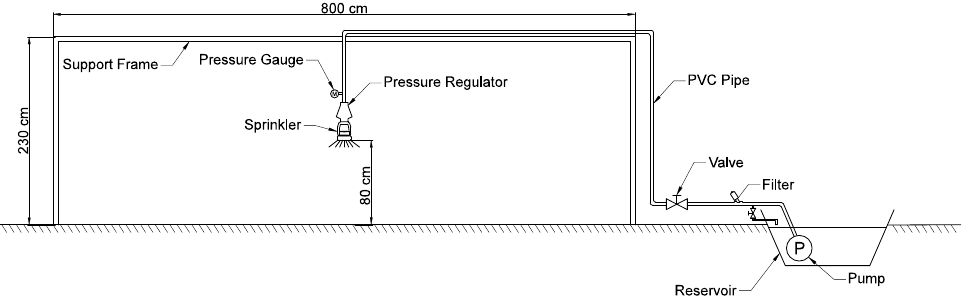
Figure 1. Schematic of the experimental system for measuring water distribution of rotating and fixed spray plate sprinklers.